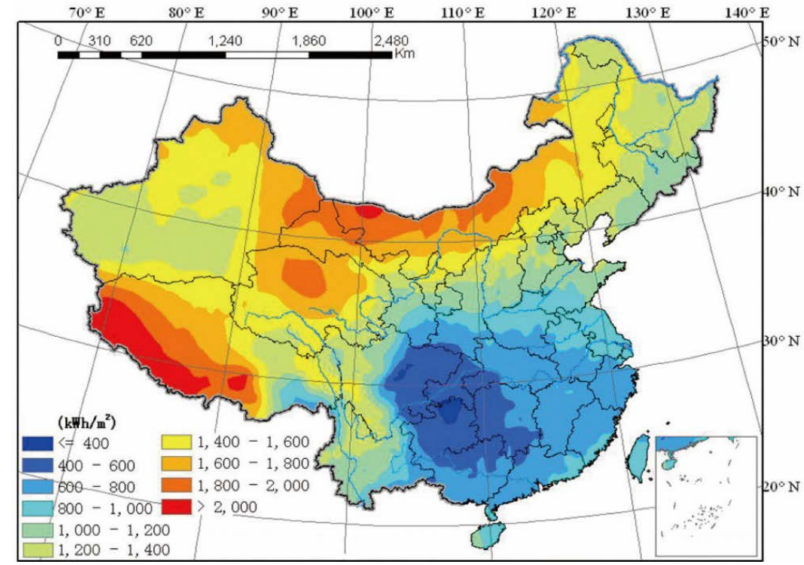
Figure 5. Distribution of solar energy resources in China. Source: China Renewable Energy